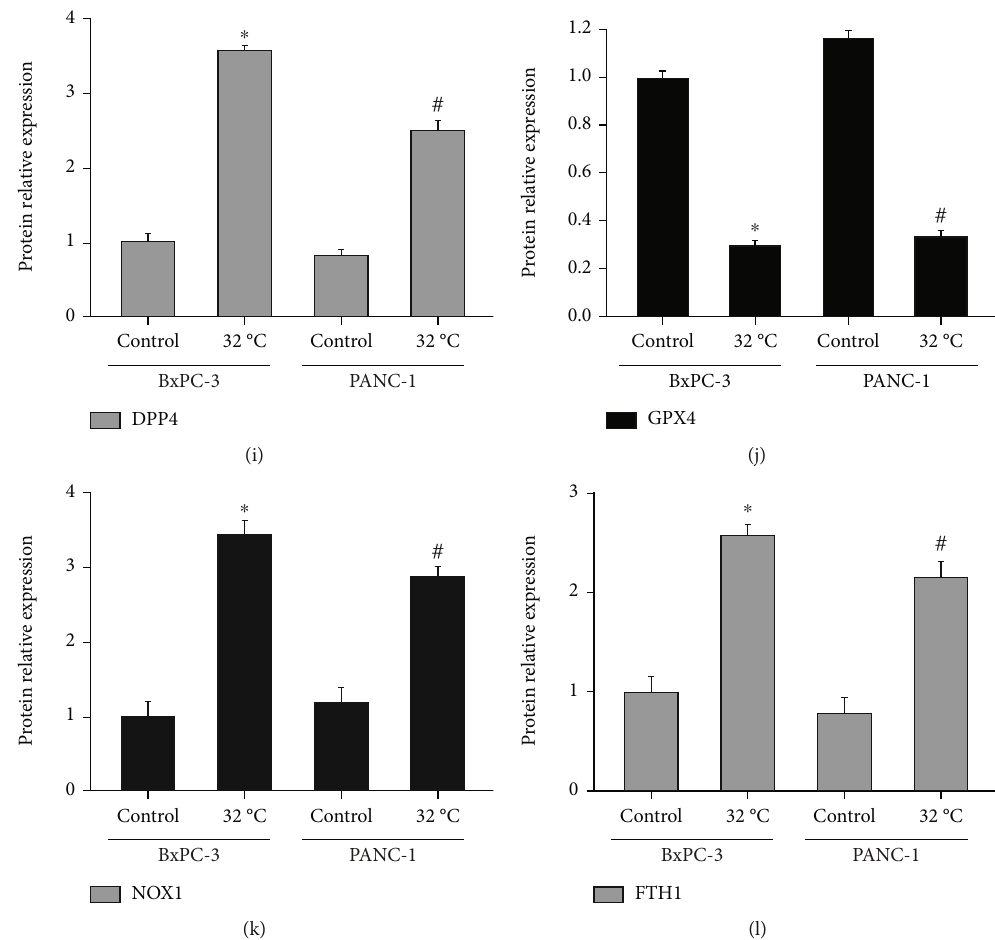
Figure 2: Cold induces CIRBP expression to a ff ect the expression of key regulatory factors of ferroptosis. (a) Searching for factors that interact with CIRBP in the GeneCards database. (b) RIP showed that CIRBP antibody signi fi cantly enriched p53 RNA. ∗ P < 0 : 05 versus IgG; # P < 0 : 05 versus CIRBP. (c) Agarose gel electrophoresis showed the expression of p53. BxPC-3 and PANC-1 cells were cultured at 37 (Control) or 32 ° C, then the expression of CIRBP (d) and p53 (e) was detected by qRT-PCR, and western blot analysis (f) was used to detect the protein expression levels of CIRBP (g), p53 (h), DPP4 (i), GPX4 (j), NOX1 (k), and FTH1 (l). ∗ P < 0 : 05 versus Control-BxPC- 3; # P < 0 : 05 versus